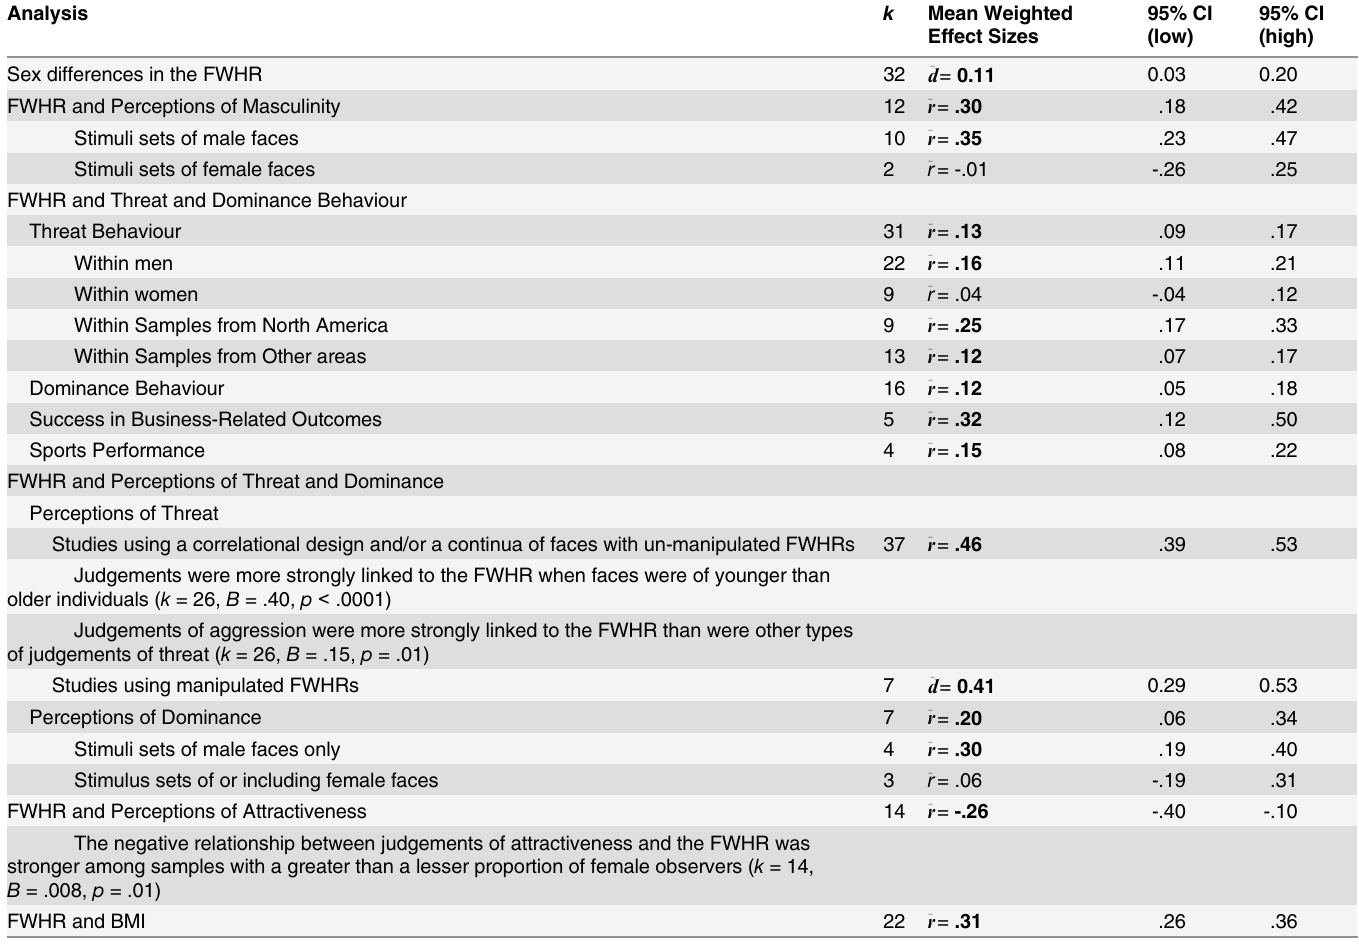
Table 1. Summary of the final results of the meta-analyses conducted in the current